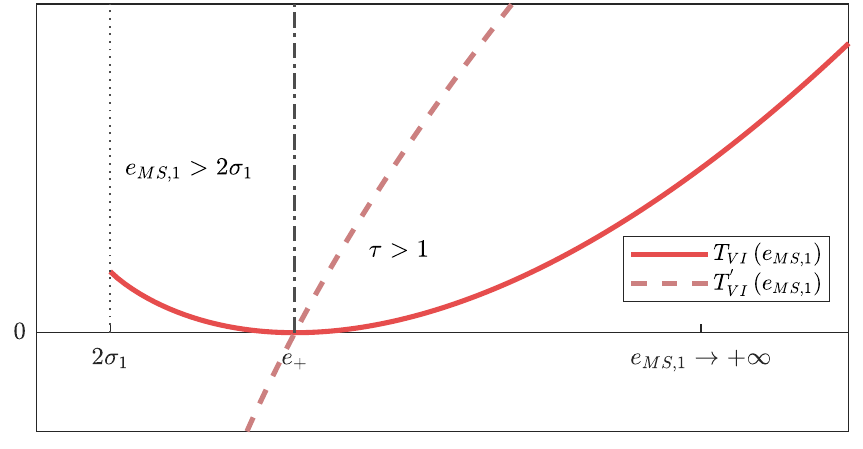
Figure A1. Tail of the function T VI and its first derivation T (cid:48) the minimum e +